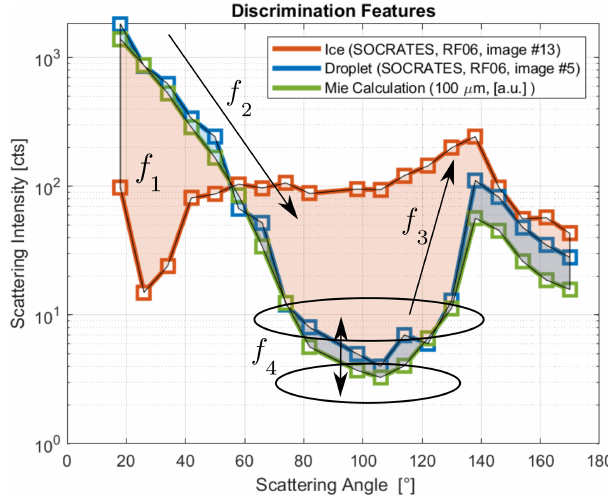
Figure 2. Visualization of the four classification features: f 1 is the Mie comparison (shaded area between curves and Mie calcu- lation); f 2 is the downslope; f 3 is the upslope before the rainbow feature; and f 4 is the ratio around the minimum at 90 ◦ . The green line shows the calculated ASF for a theoretical spherical particle. The blue area and lines show the measured ASFs of an exemplary droplet ( D = 119.6µm) and ice crystal ( D = 165.8µm) from the SOCRATES